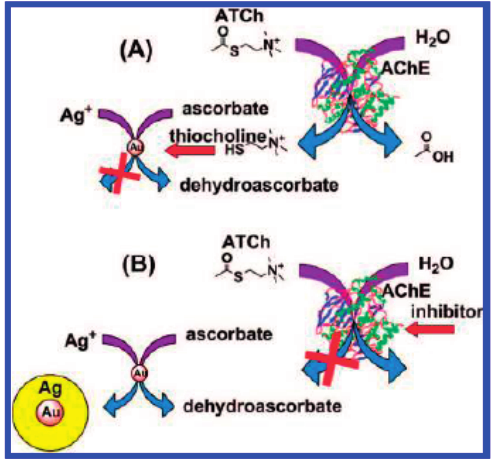
Figure 2. Detection of acetylcholine esterase inhibitors by growing silver-coated gold nanoparticles. Reprinted with permission from [34]. Copyright 2009 American Chemical